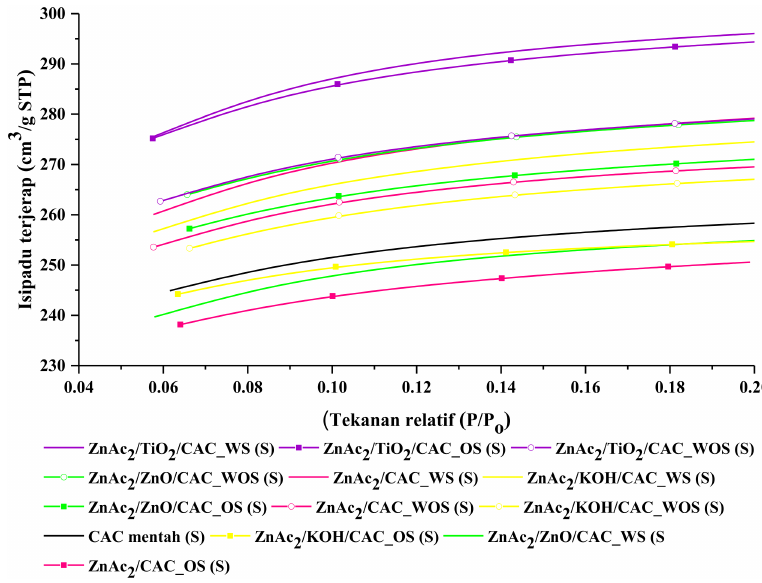
Figure 7. N 2 adsorption-desorption